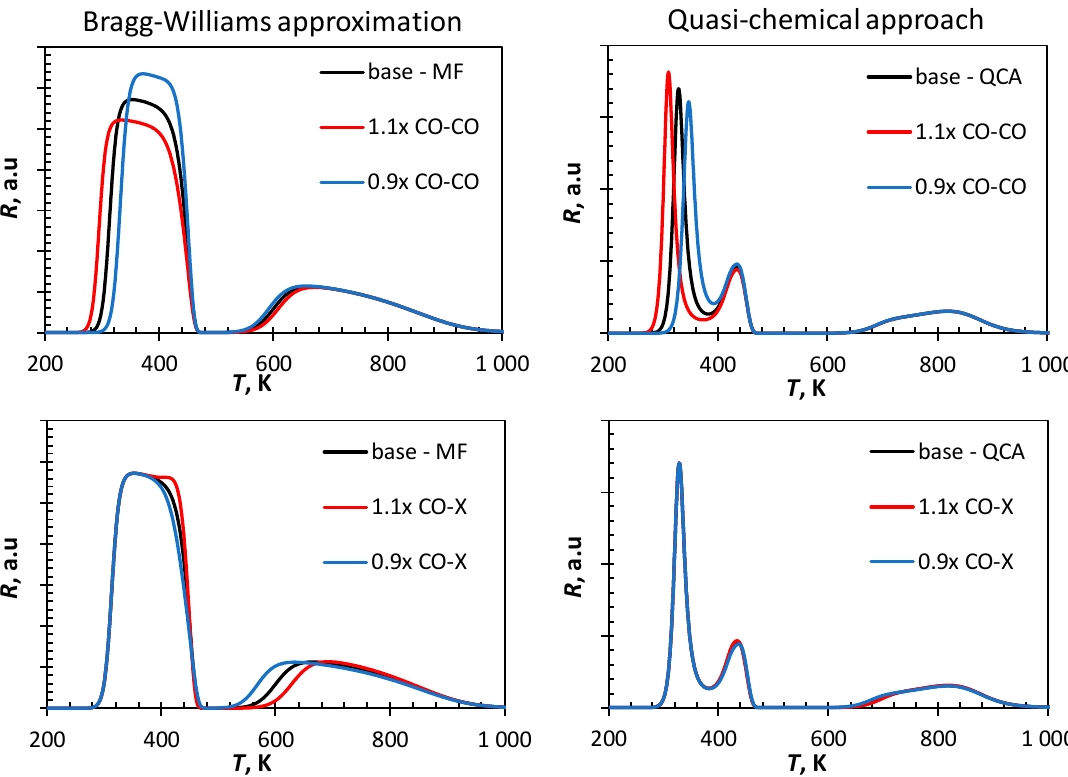
Figure 3. Sensitivity analysis of simulated CO-TPD-profile from Fe(100) ( Θ CO,initial = 1.00 ML, 10 K · s − 1 ) using a mean field approach on the variation in the lateral interaction ( top : increasing/decreasing CO-CO interactions by 10%, bottom : increasing/decreasing CO-C and CO-O interactions by 10%).